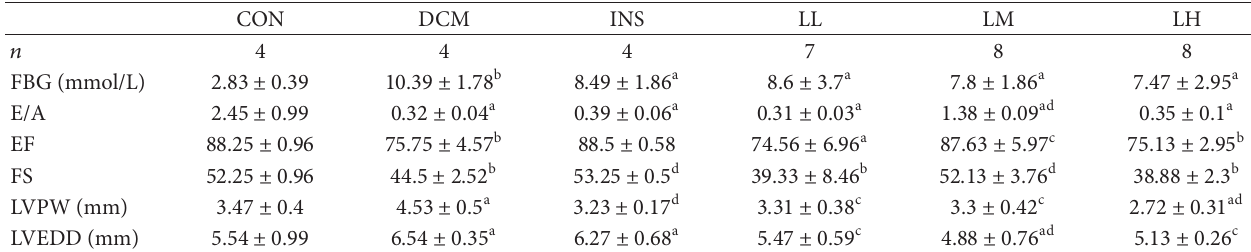
Table 1: Echocardiographic and fasting blood glucose data.